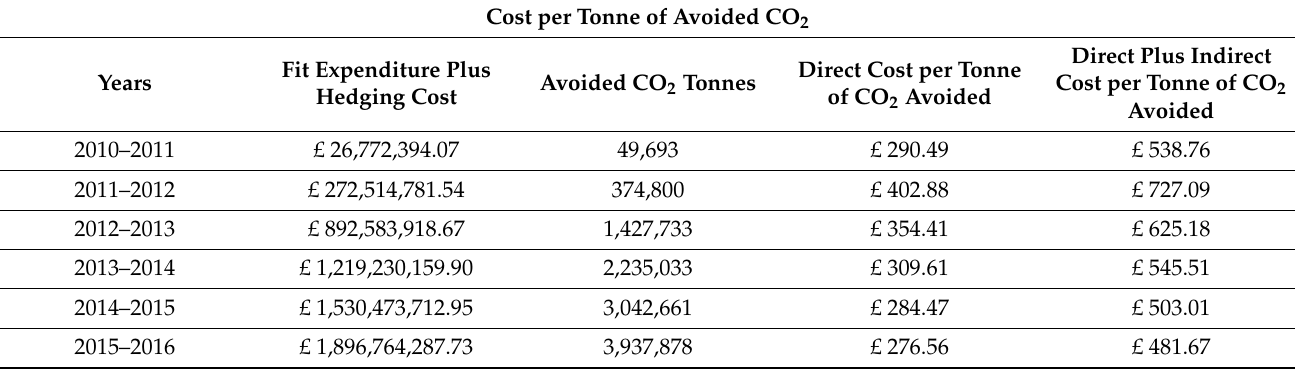
Table 8. Cost per tonne of avoided CO 2 under the Feed-in Tariff (FiT) Scheme. Cost per Tonne of Avoided CO